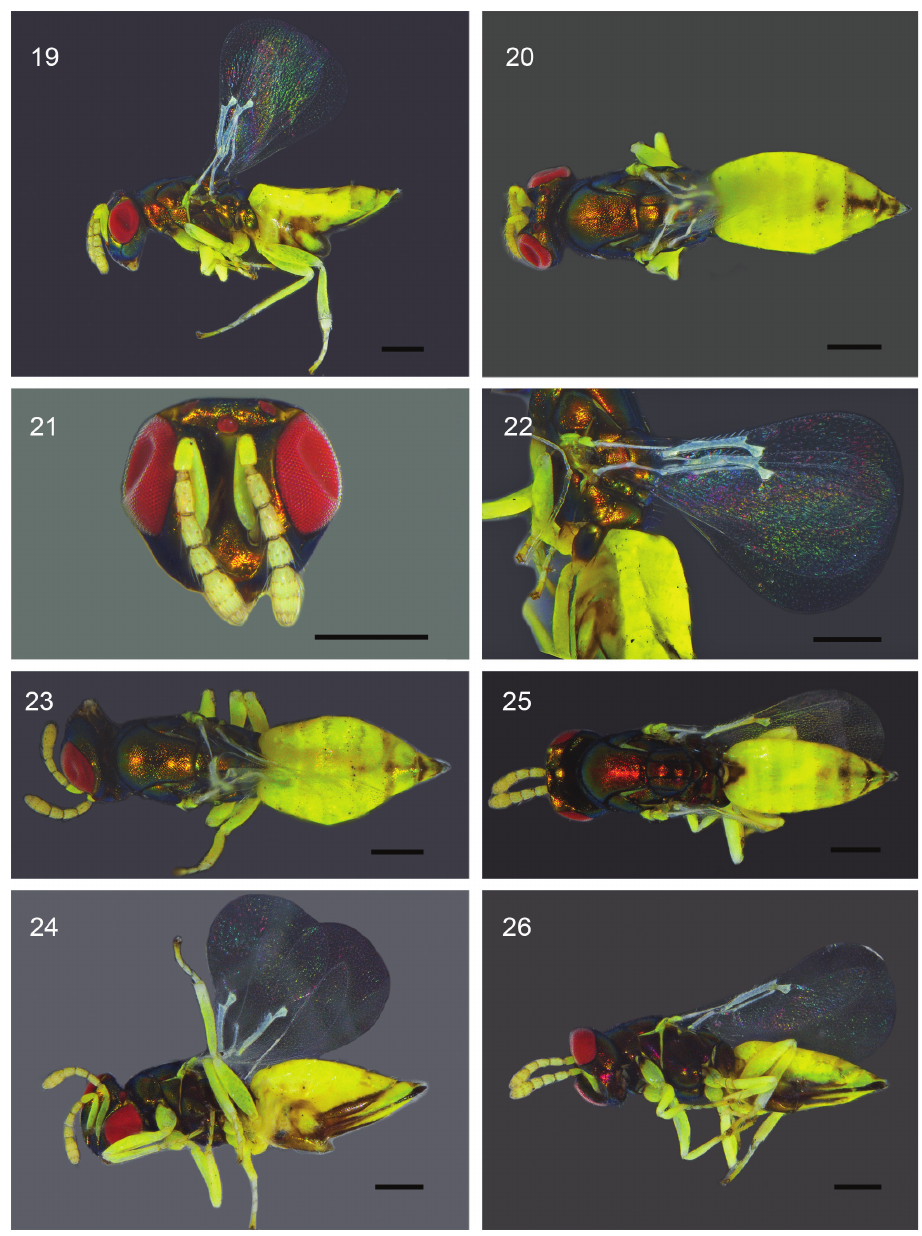
Figures 19–26. Dzhanokmenia yuxuannis , female ( 19–22 holotype 23–26 paratypes): 19 habitus,